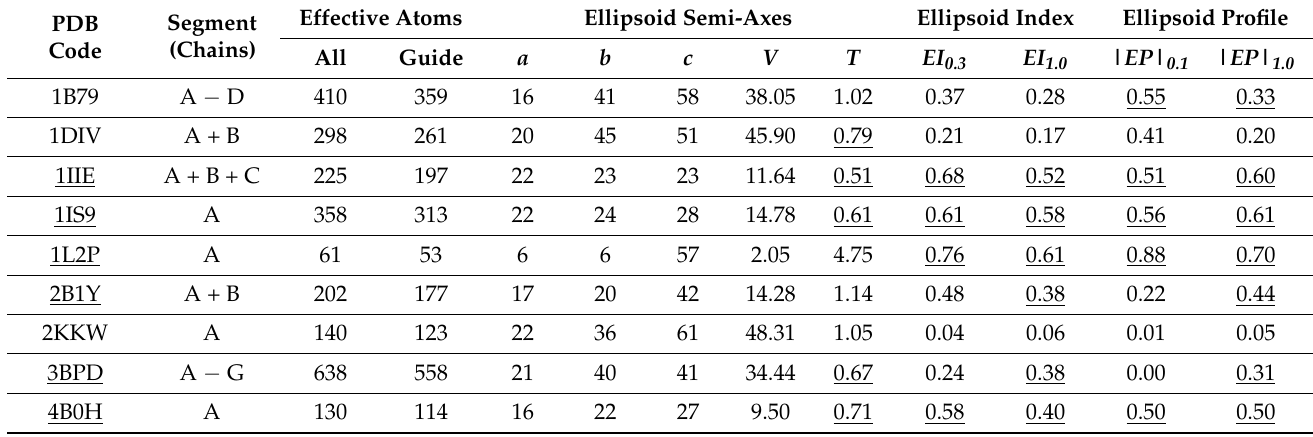
Table 3. Results of application of EP algorithm to selected segments of proteins from Table 1 using m = 3. Underline values promote globular status. Underlined PDB codes denote structures deemed globular: single line—partially ( EI 1.0 ≥ 0.3, 0.3 ≤ EI 0.3 <